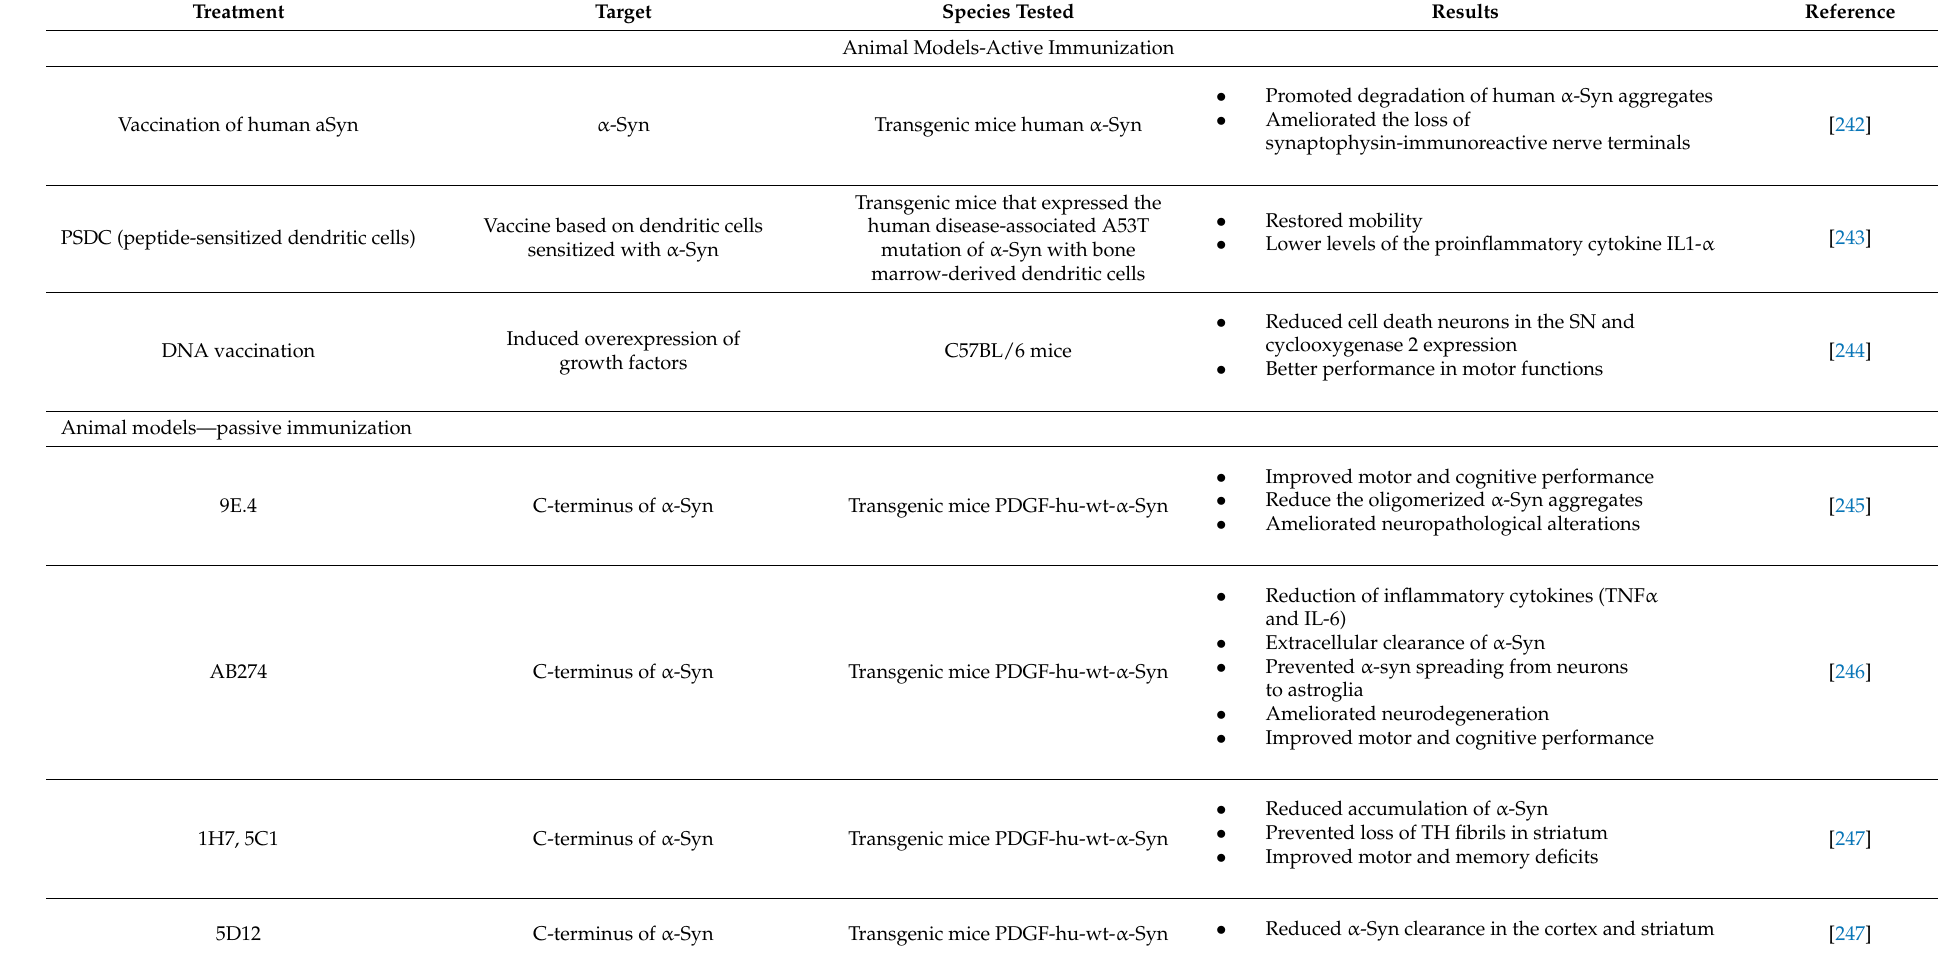
Table 1. Treatments for neuroinflammation in Parkinson’s disease animal